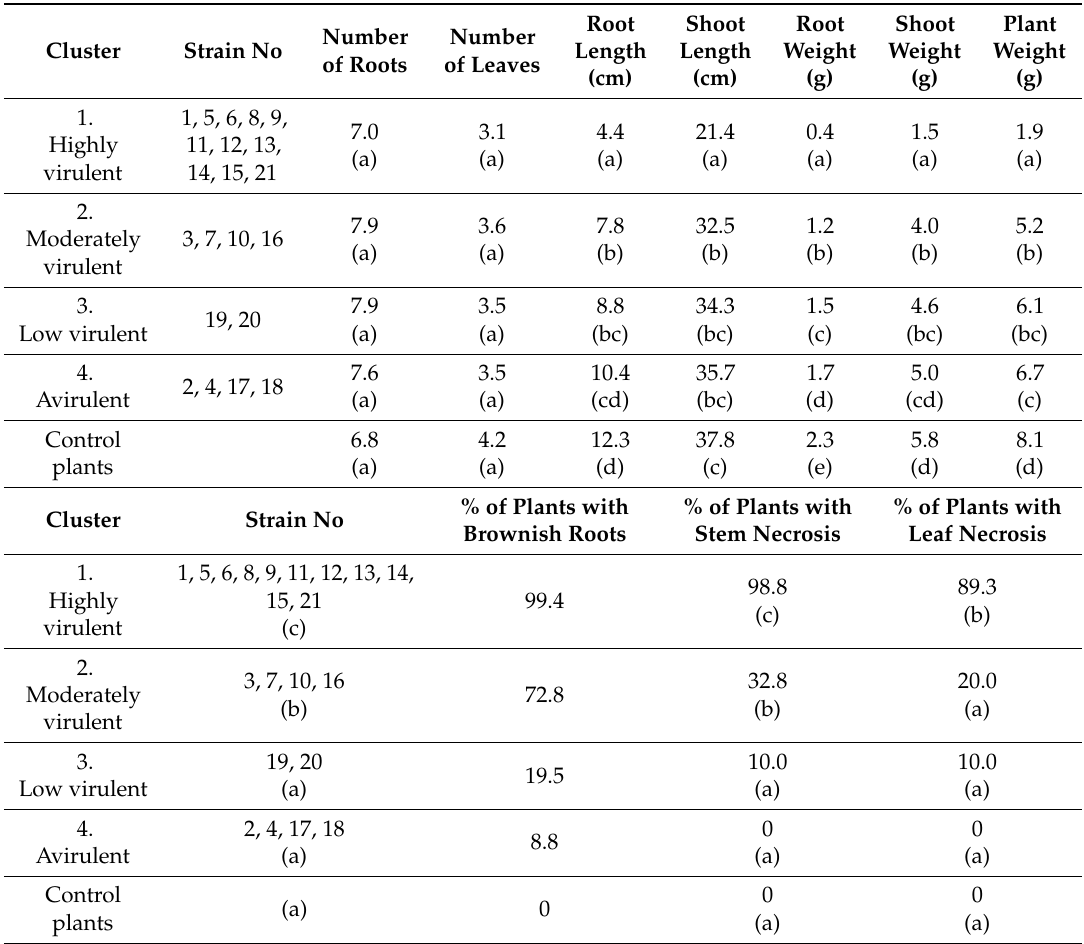
Table1. Meanvaluesoftheassessedparametersoftheryeplantsinfectedbytheisolated Microdochiumnivale strains of different clusters: 1. highly virulent, 2. moderately virulent, 3. low virulent, and 4. avirulent. The following parameters of the plants were analyzed: number of roots, number of leaves, root length, shoot length, the weight of roots of 10 plants, the weight of shoots of 10 plants, the weight of 10 plants, thepercentageofplantswithbrownishroots,thepercentageofplantswithstemnecrosis,andthepercentage of plants with leaf necrosis. Clusters that do not share the same letter (given in brackets) have significantly different means in pairwise comparison (Duncan’s multiple range